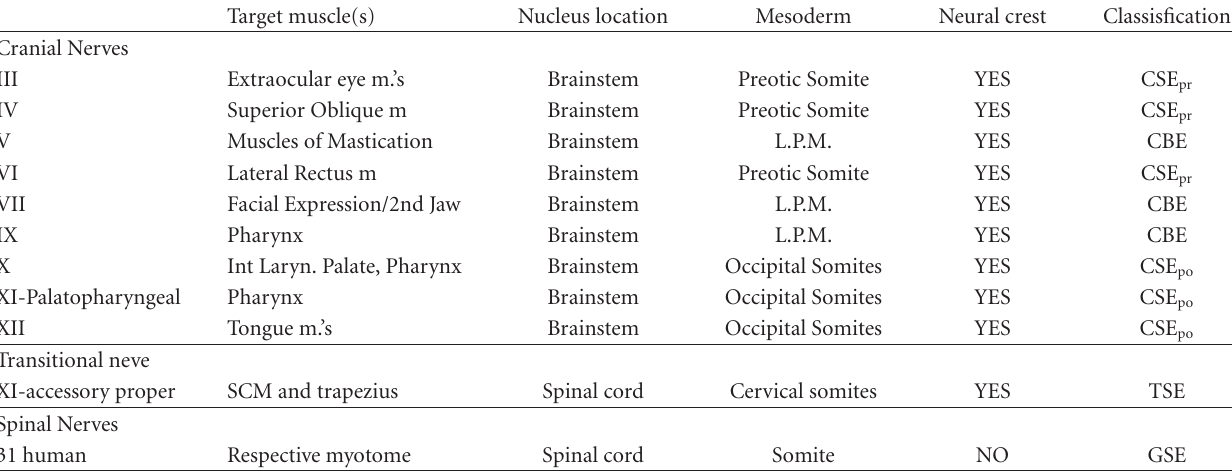
Table 1: Classification of the e ff erent peripheral nerves innervating striated musculature based on embryological and anatomical findings. All cranial nerves have a nucleus within the brainstem and receive mesenchymal contributions from neural crest cells. The cranial nerves can be subdivided into 3 groups. CSEpr cranial nerves innervate striated muscle derived from preotic somites. CSEpo cranial nerves innervate striated musculature from postotic somites, while CBE cranial nerves innervate striated muscle developing from somitomeres (head mesoderm). Spinal nerves have a nucleus within the spinal cord and muscles of somitic origin. Trunk Mesenchyme also forms from the mesodermal layer. The transitional nerve (accessory proper) has a nucleus within the spinal cord, innervates muscle derived from somites, and has mesenchymal elements that form from neural crest cells, thus making it a unique peripheral nerve. It is important to note that the eleventh crania nerve is represented entirely by the laryngopalatopharyngeal motor (LPP) formerly the cranial root of the accessory.